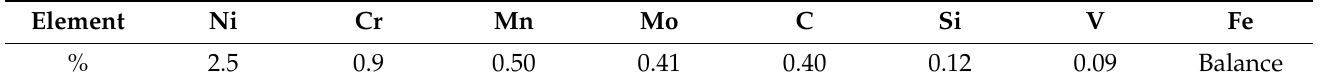
Table 1. Chemical composition of AISI 4340 [6].